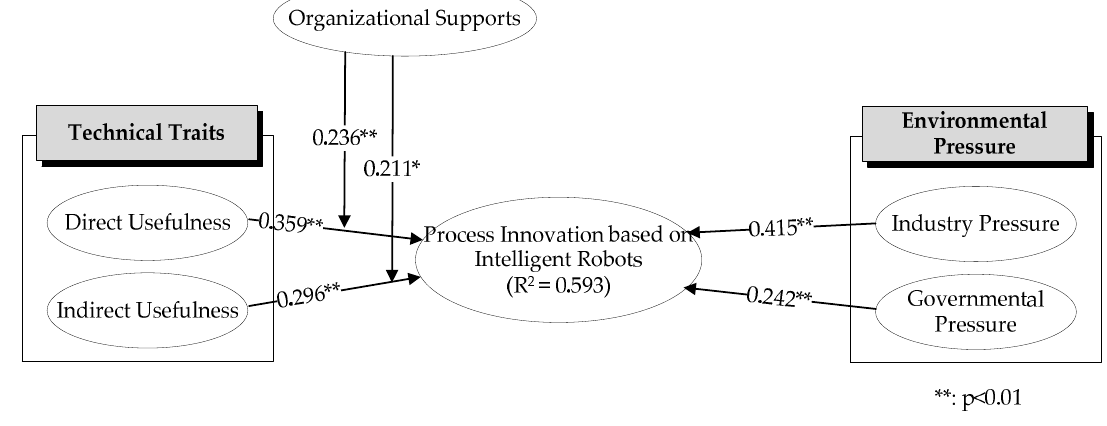
Figure 2. Results of the structural model. Table 5. Summary of hypothesis tests (H1–H6).